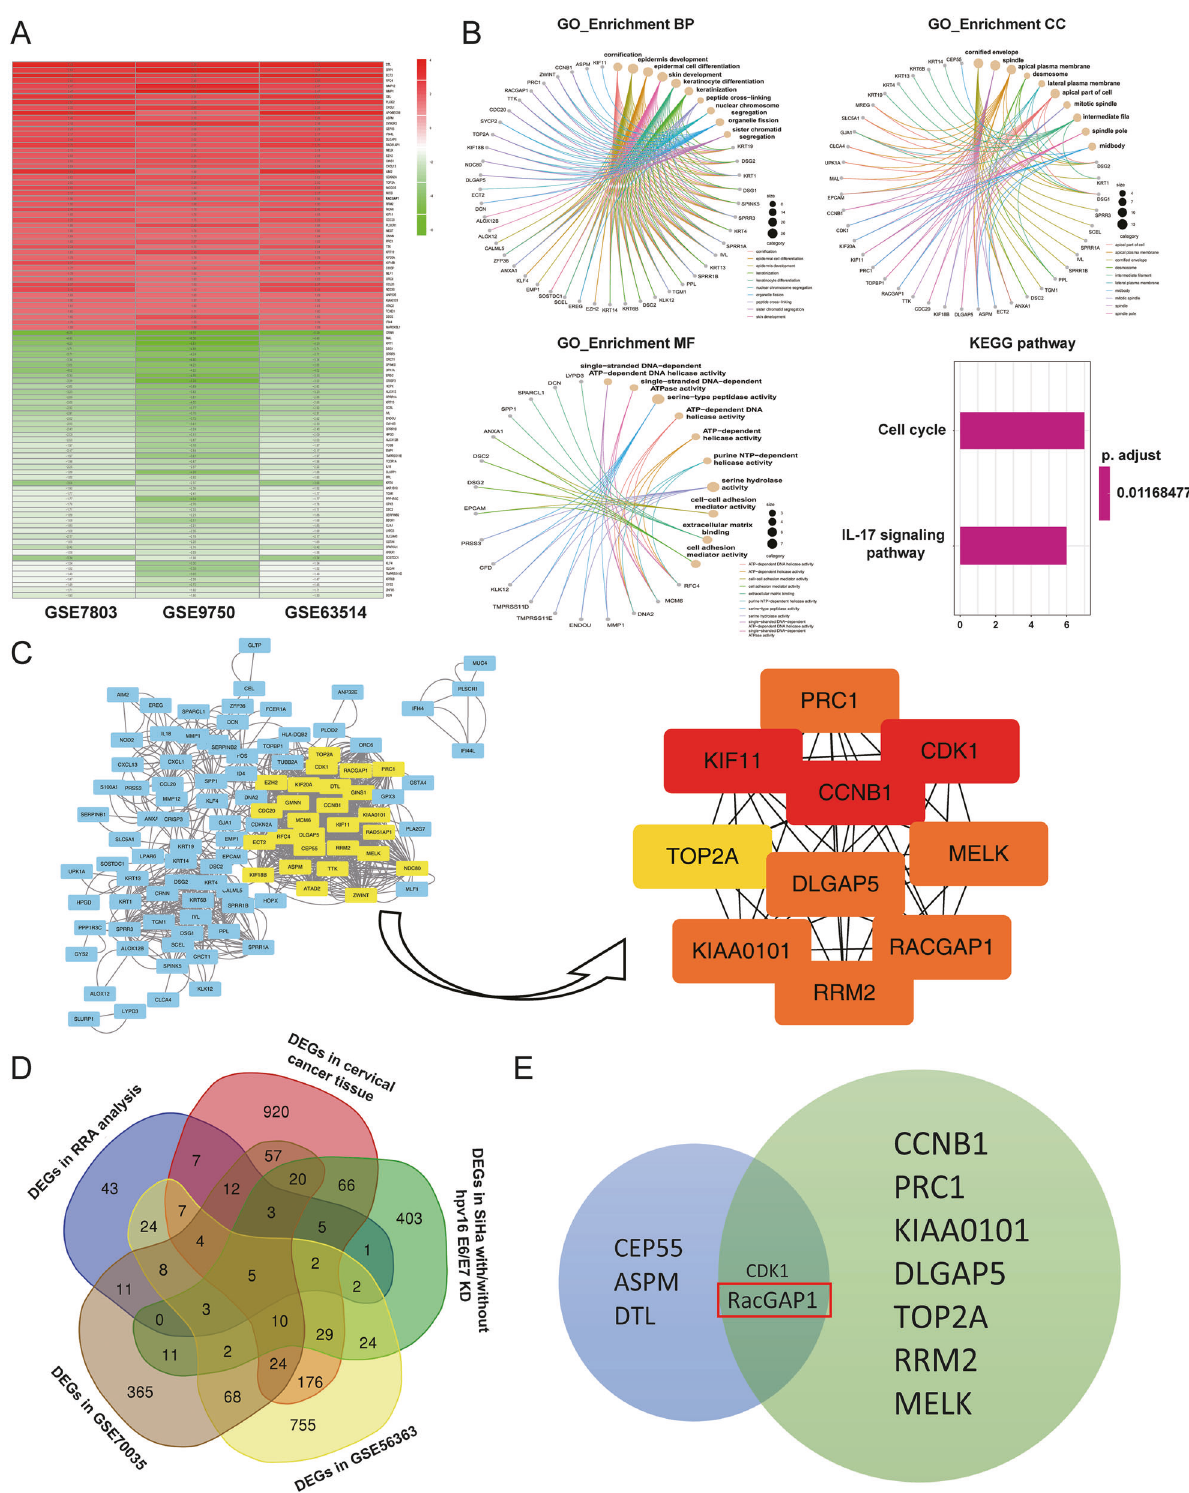
Fig. 1 Bioinformatics analyses of cervical cancer. A Identi fi cation of robust DEGs of GSE7803, GSE9750, and GSE63514 by RRA analysis. Heatmap showing the top 50 upregulated genes and top 50 downregulated genes according to logFC. Each row represented one gene and each column indicates one dataset. Red indicates upregulation and green represents downregulation. The numbers in the heatmap indicate logarithmic fold change in each data set calculated by the “ limma ” R package. B GO analysis and KEGG analysis for DEGs from RRA analysis. C PPI network and the hub gene module of DEGs. D DEGs among the mRNA expression pro fi ling datasets RRA analysis, cervical cancer tissue, SiHa with/without HPV16 E6/E7 KD, GSE56363, and GSE70035. An overlap of fi ve genes was observed among the fi ve data sets. E Two genes were found by overlapping 10 PPI hub-genes and fi ve hub DEGs. DEG differentially expressed gene, GEO Gene Expression Omnibus, RRA robust rank aggregation, GO Gene Ontology, KEGG Kyoto Encyclopedia of Genes and Genomes. PPI protein – protein interaction, CDK1 cyclin- dependent kinase 1, RacGAP1 Rac GTPase-activating protein 1. Cell Death and Disease (2022)